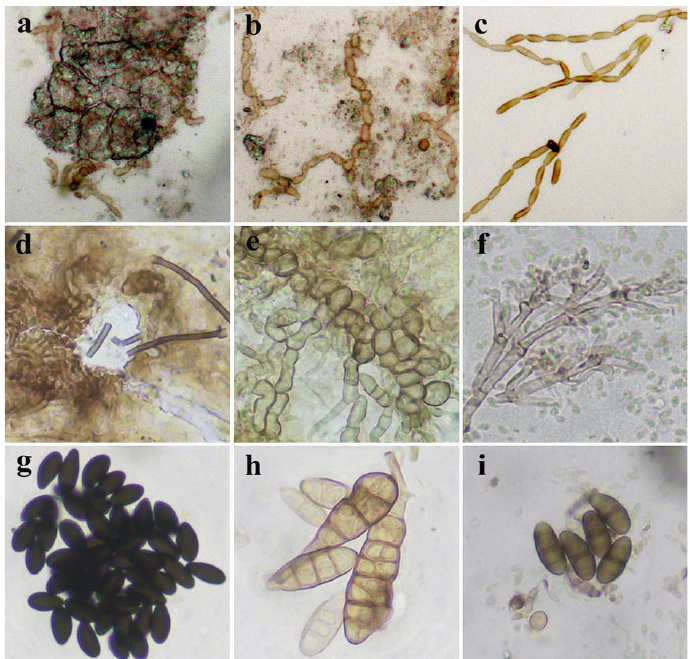
Figure 5. Optical micrographs of fungal structures in adhesive tape samples from fresco painting ( a – c ) and wooden iconostasis ( d – i ): ( a – c ) Neodevriesia conidial chains on deteriorated fresco surface; ( d , e ) fungal structures permeating lacquered wood surface; ( f ) branched geniculate terminal conidiophore of the anamorphic state of Hypoxylon ; ( g ) inequilaterally ellipsoid Hypoxylon ascospores in mass; ( h ) Alternaria-like dictiospores; ( i ) Dematiaceous hyphomycetes fragmospores, (400 ×). Observations made with optical microscopy were additionally confirmed with SEM: Neodevriesia conidial chains were found permeating the plaster below the painted layer (Figure 6a–c), while on the iconostasis a mass of branched conidiophores of the ana- morphic state of Hypoxylon (Figure 6d) and details of conidiogenous apparatus (Figure 6e,f) were observed.